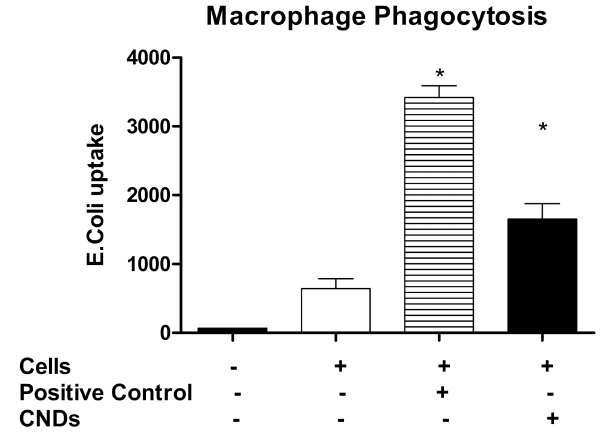
Figure 6. Increase in phagocytic activity in CND co-treated cells. THP-1 cells (2 × 10 6 ) were treated with 3 ng/mL TPA in the presence or absence of 0.1 mg/mL CNDs. Cells were incubated for a period of 72 h, upon which media was refreshed, and followed by another incubation period of 72 h. Cells were harvested, and a sample of control cells were treated with 1000 ng/mL TPA to serve as a positive control. Cells were distributed in a 96-well plate and left to incubate for 18 h. Treatment of cells with fluorescent E. coli suspension followed for 2 h, upon which the suspension was removed. Cells were finally treated with Trypan Blue. The removal of Trypan Blue preceded the reading in a